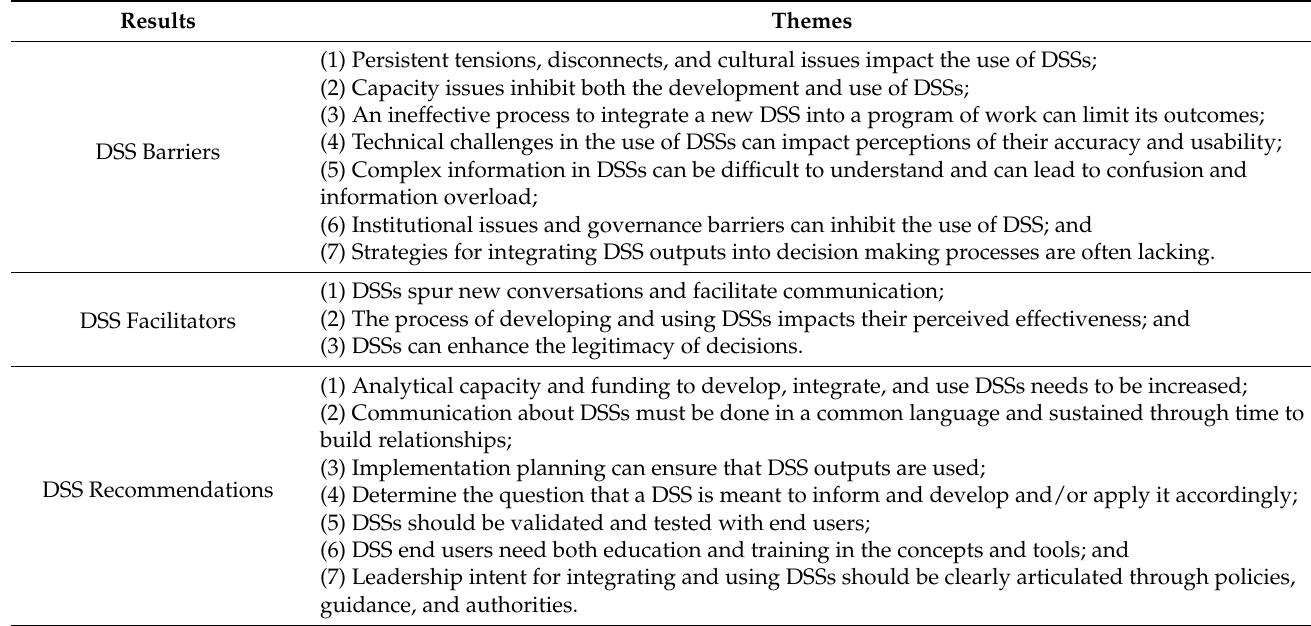
Table 5. Key themes from results on DSS barriers, facilitators, and recommendations.